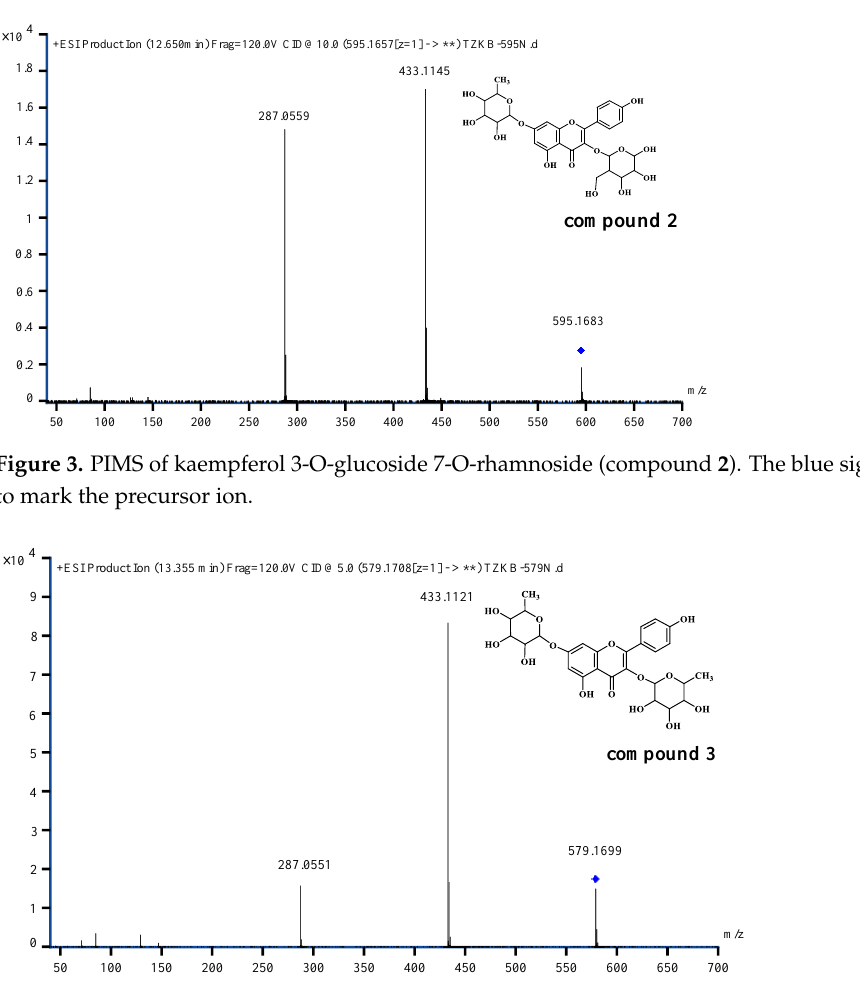
Figure 2. PIMS of kaempferol-3-O-rhamnosyl-glucoside-7-O-rhamnoside (compound 1). The blue sign was used to mark the precursor ion.